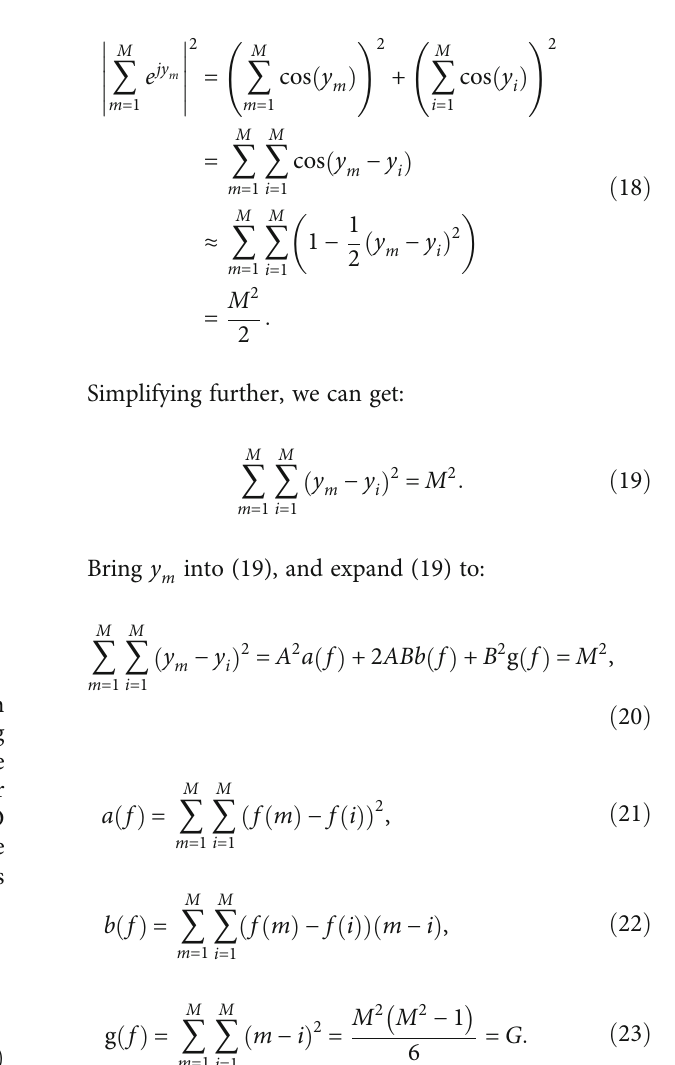
Figure 2: The signal processing at receiver.